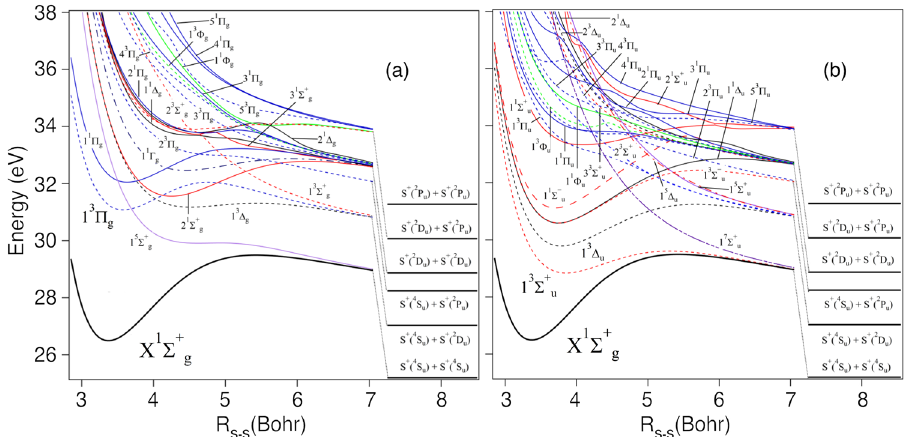
+ 2 of ( a ) gerade symmetry and ( b ) + 1 (cid:31) + g ) at the equilibrium bond distance. 2 (X